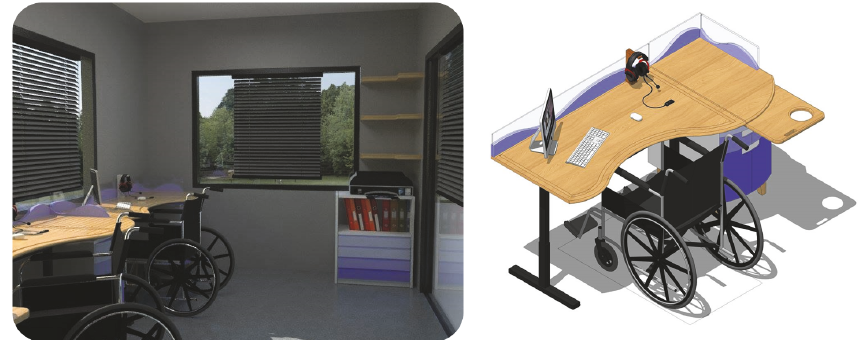
Figure 2: Design of a work table, side filing cabinet, and wall cabinet. The work table is adjustable, up and down. The side filing cabinet has an adjustable storage compartment and a wall cabinet that is more easily accessible [2]. Source: the current